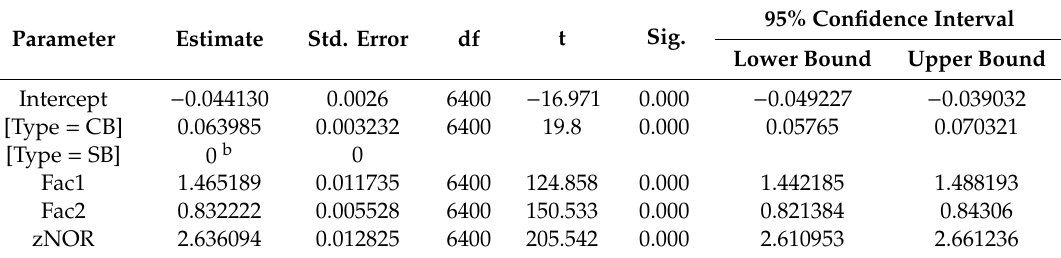
Table 9. Estimates of fixed e ff ects a,c .